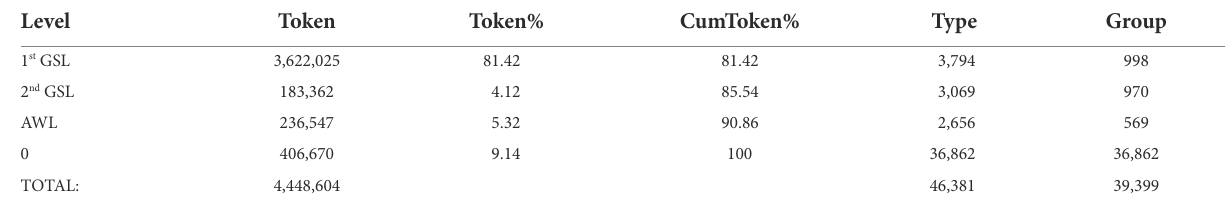
TABLE 2 The lexical profile of MOOC lectures based on GSL/AWL lists.